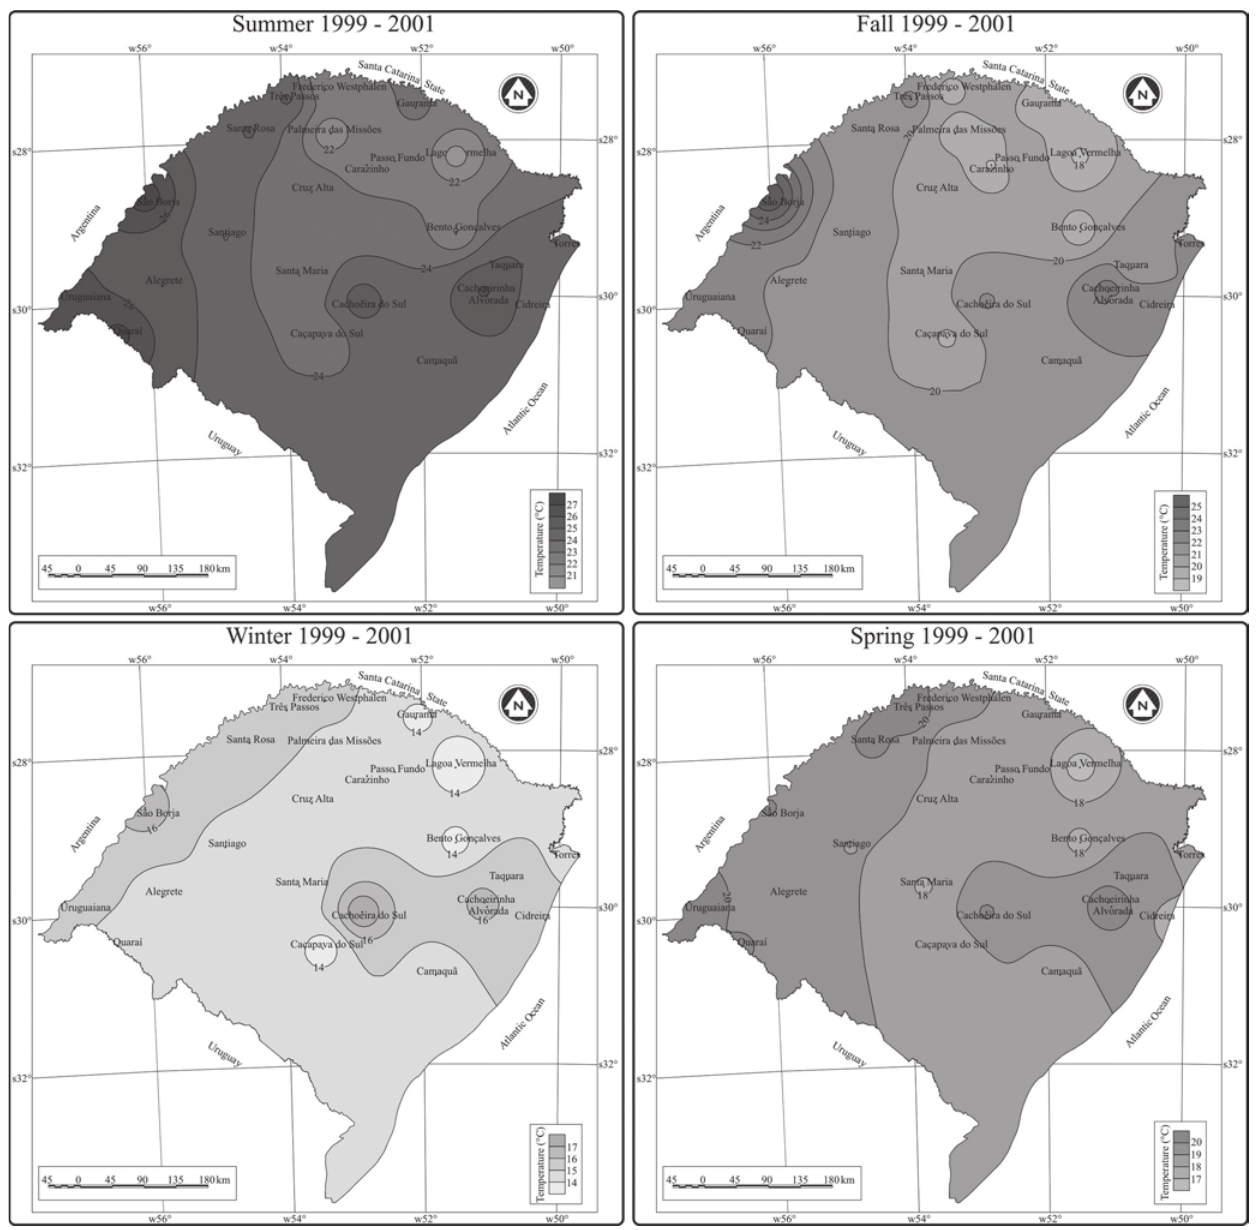
Fig. 2. Mean water temperature in several cities of the state of Rio Grande do Sul from 1999 to 2001 (Source